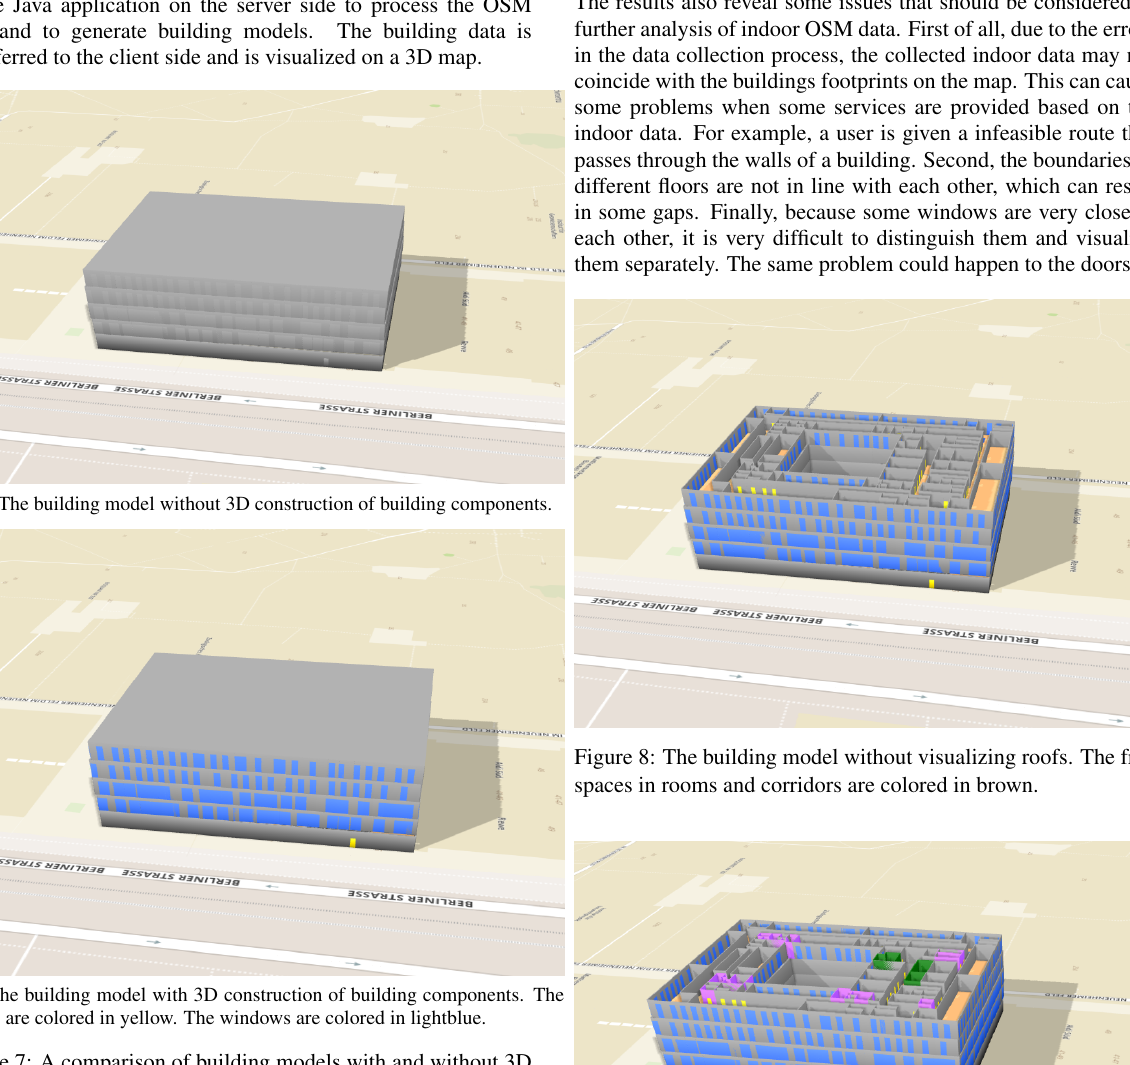
Figure 7: A comparison of building models with and without 3D construction of building components (windows and doors).